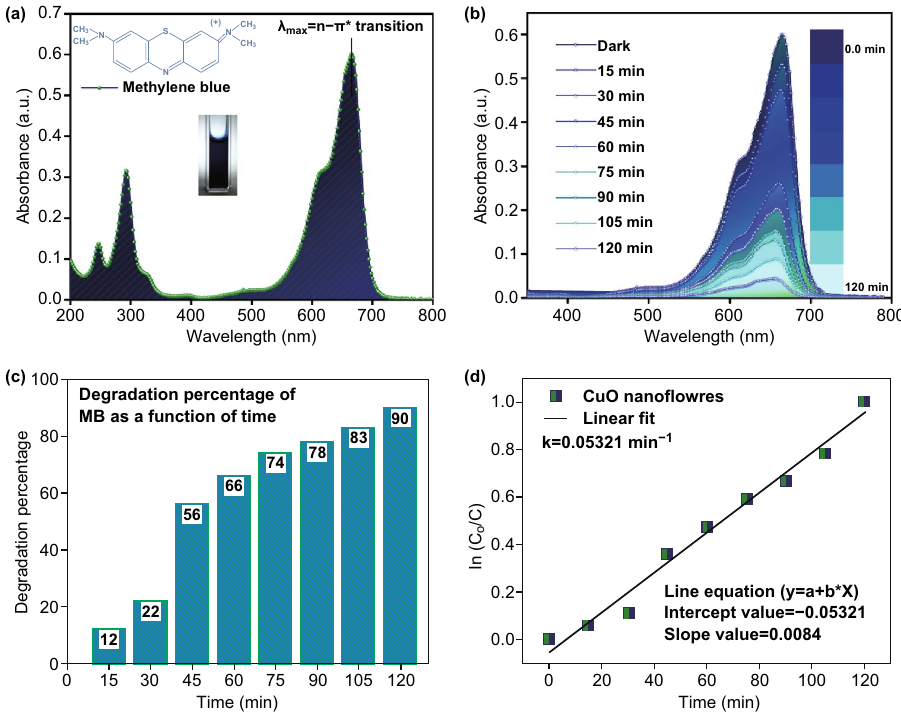
Fig. 3 a UV–vis absorption spectrum of MB dye, b spectral variation of MB dye in different time intervals, c photocatalytic degradation of MB dye under the irradiation of light over eugenol-assisted CuO nanoflowers. d First-order kinetic plot of ln( C 0 / C ) versus time for the degradation of MB dye. (Color figure